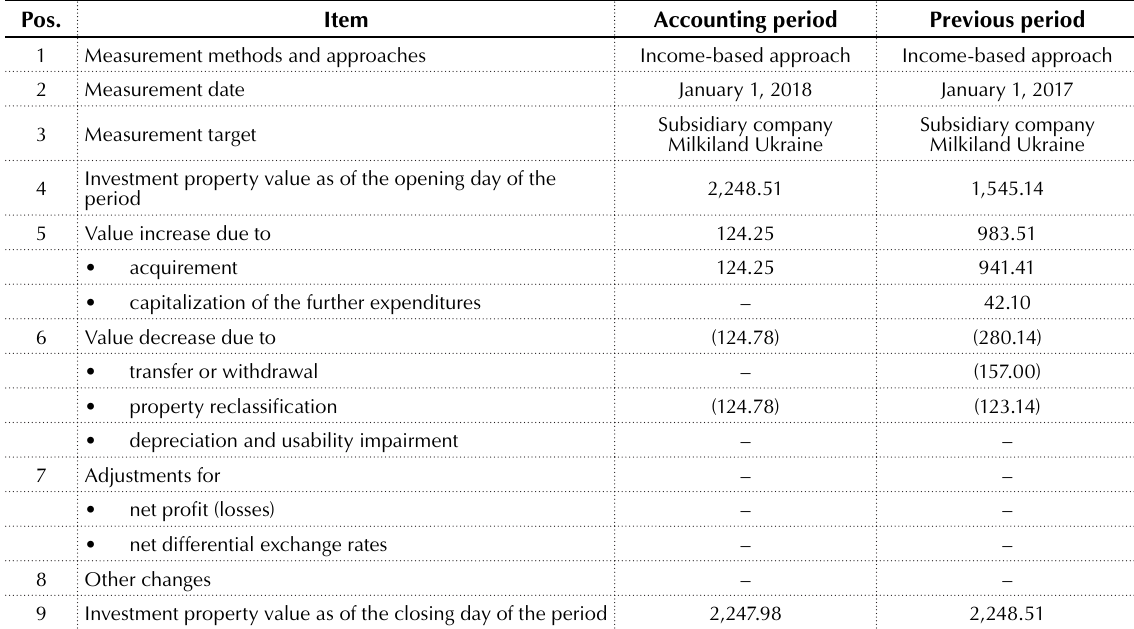
Table 3. Standard form for reporting of changes in the investment property value, UAH thousand